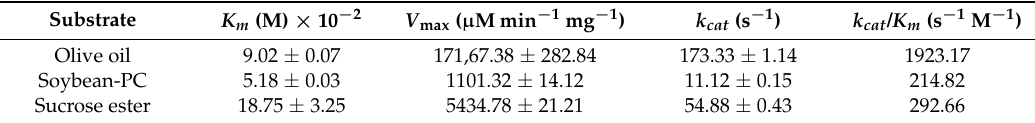
Table 2. Apparent kinetic parameters of rGZEL to three substrates tested by the emulsified method. Substrate